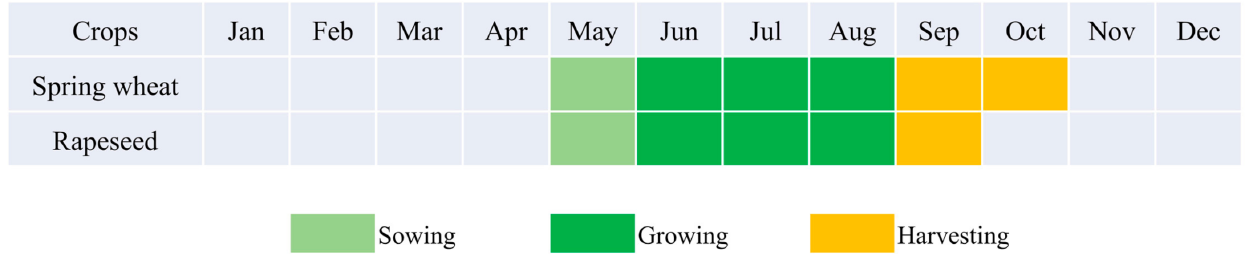
Figure 3. Crop calendar of spring wheat and rapeseed in the study